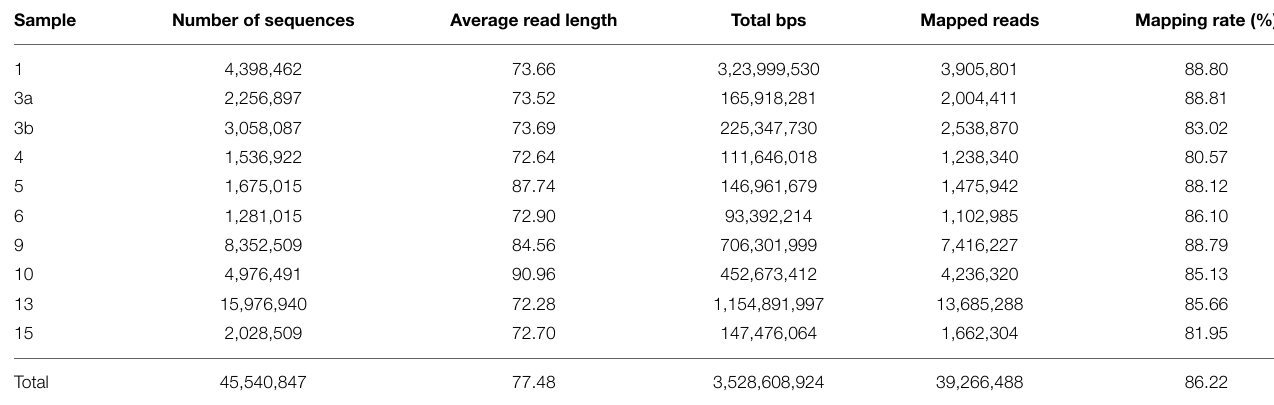
TABLE 5 | Sequence statistics of the quality trimmed and rRNA depleted metatranscriptomic data sets used for mapping. Sample Number of